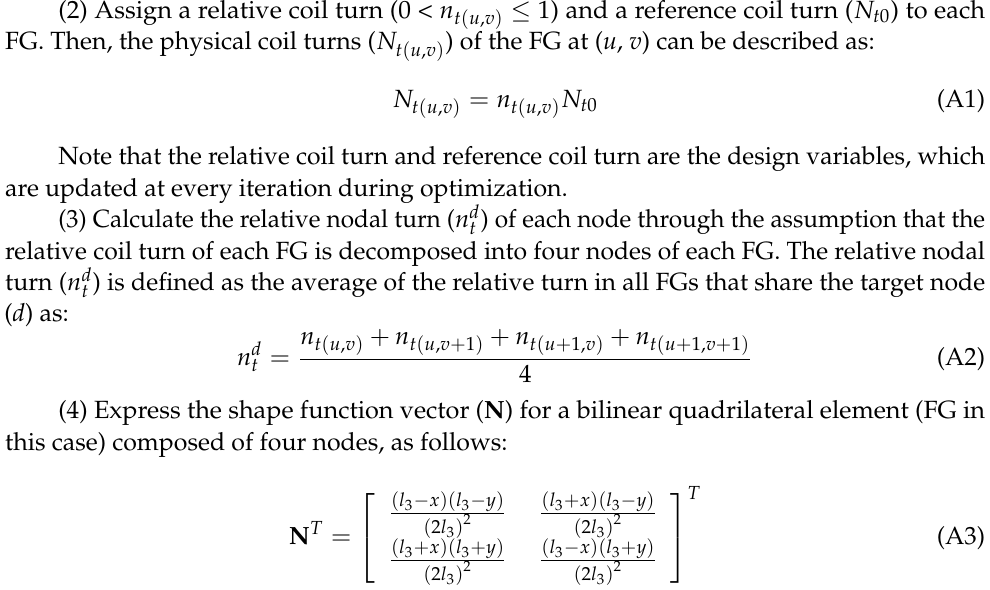
Figure A1. Fixed grid (FG)-based design domain representation for the transmitter coil.